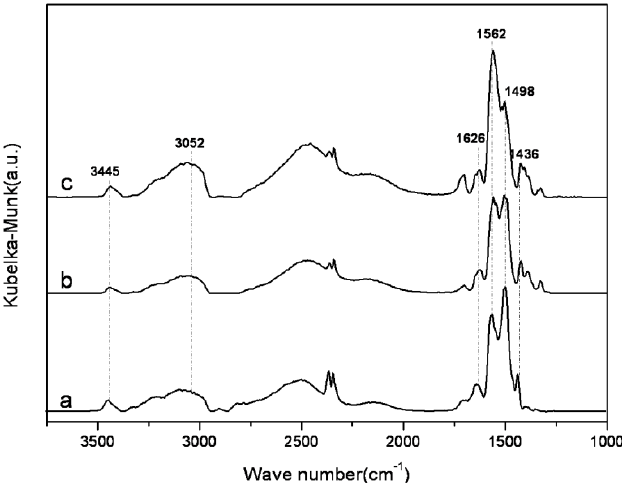
Figure 9. In situ DRIFTS spectra of amine-grafted SBA-15-ex. a: APTMS-SBA-15-ex;